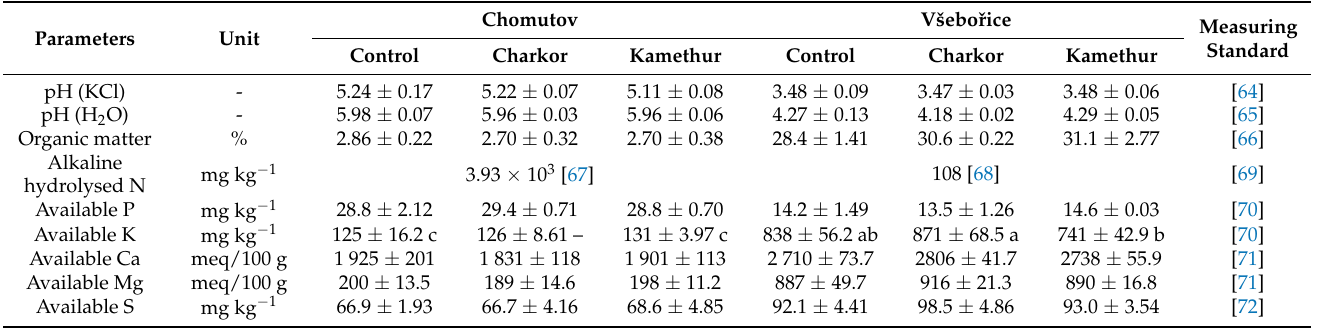
Table 1. The agrochemical characteristics of soils in the pot experiment. Different letters indicate a significant difference between the values within one parameter ( p < 0.05).